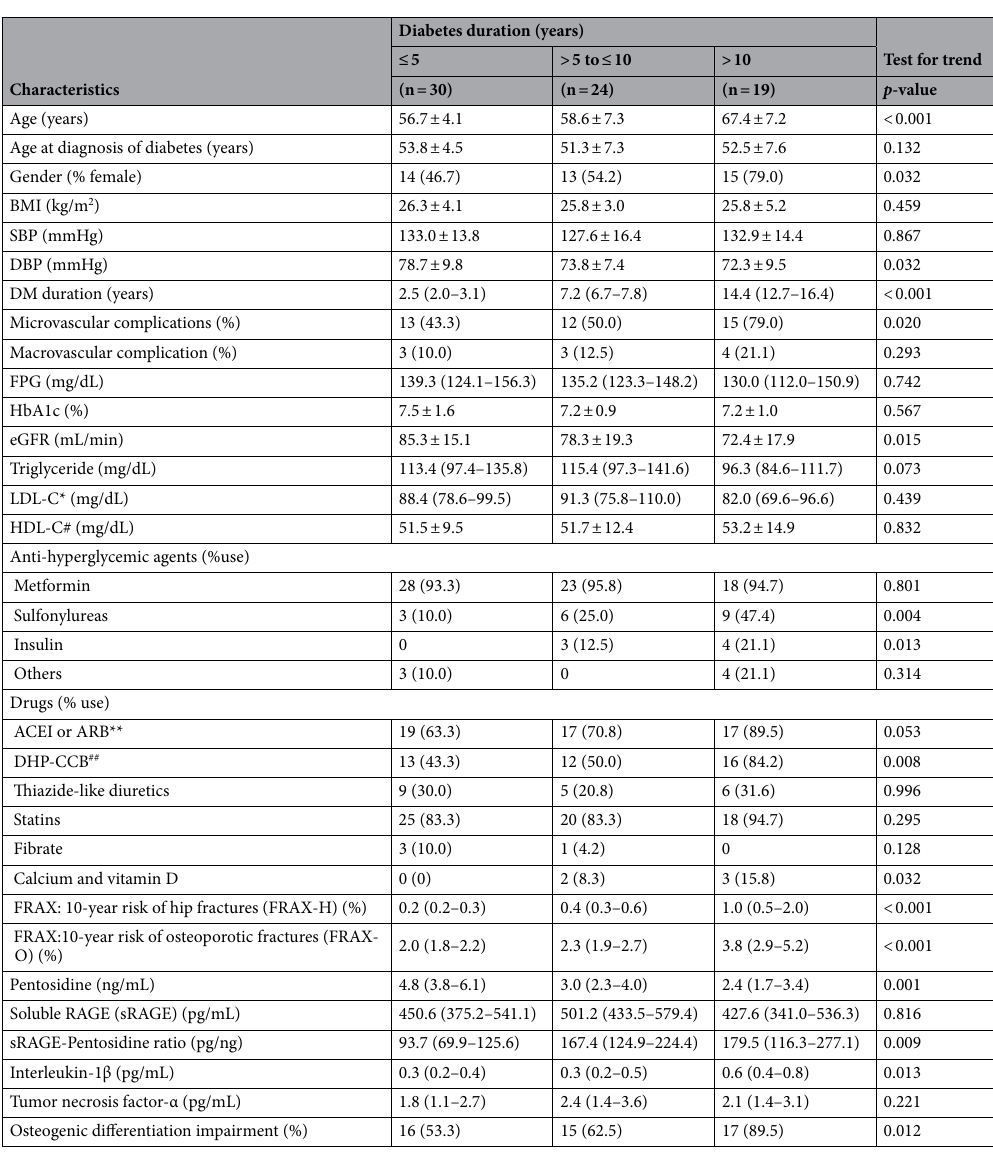
Table 3. Clinical characteristics of the study participants with type 2 diabetes. *LDL-C: low-density lipoprotein cholesterol; #HDL-C: high-density lipoprotein cholesterol. **ACEI: angiotensin-converting enzyme inhibitors; **ARB: angiotensin II receptor blockers; ## DHP-CCB: dihydropyridine calcium channel blockers.